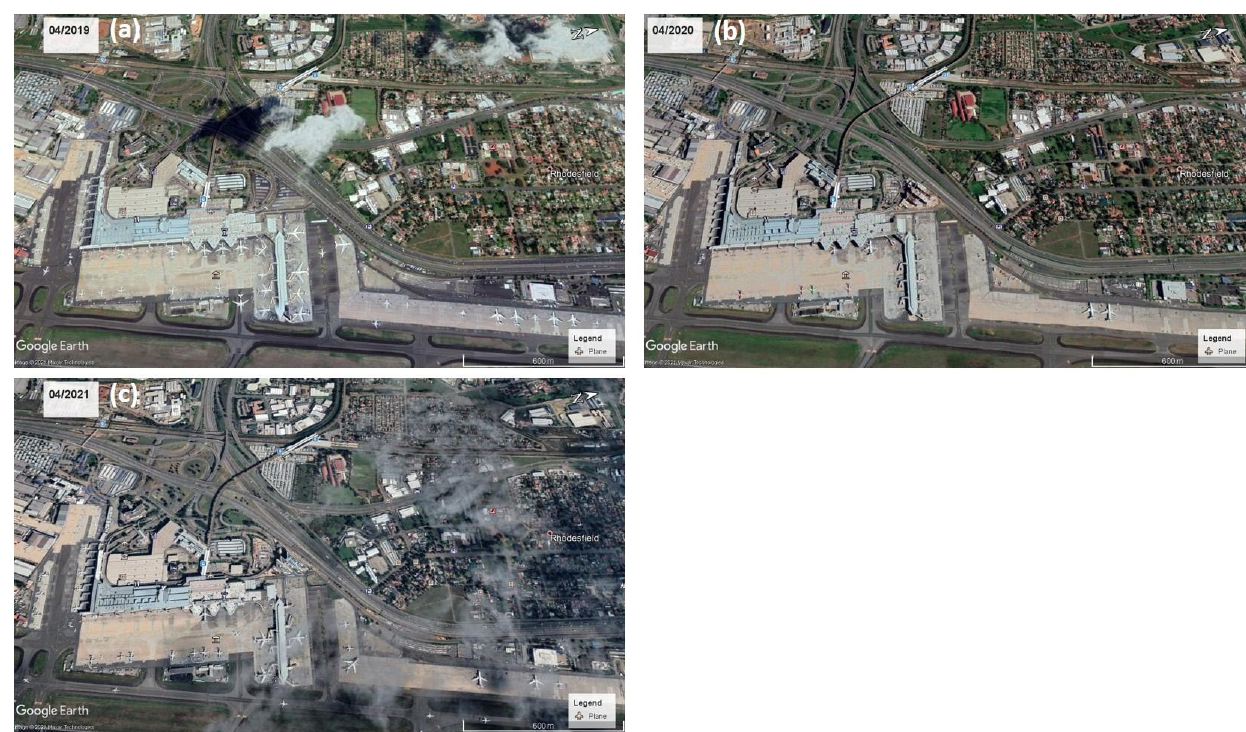
Figure 3. Google Earth image of OR Tambo International Airport (FAOR) ( a ) before the Level-5 lockdown, ( b ) during the lockdown Level-5, and ( c ) after the Level-5 lockdown.